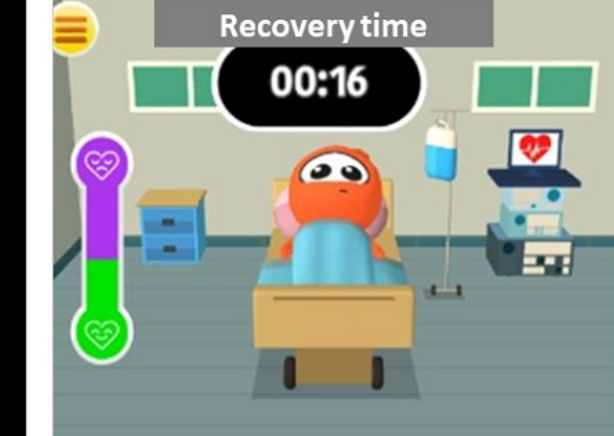
Figure 7. Hospitalization alert symbolized by an ambulance and the infirmary setting. The thermometer icon on the left side of the character's bed uses color to indicate the recovery and discharge